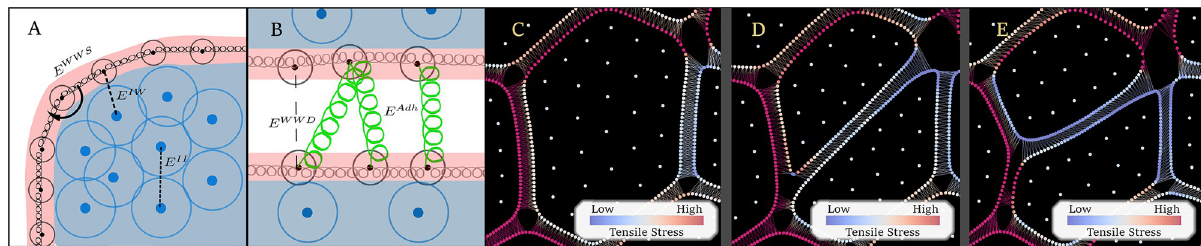
Fig 10. Two-dimensional multi-scale model of SAM growth and maintenance. Simulated cells are represented by two collections of nodes: cell wall nodes (solid black dots in the red region in A and B) and internal nodes (solid dark blue dots in the blue region in A and B). (A) Adjacent wall nodes of the same cell are shown interacting via linear and rotational springs given by E WW that represent mechanical stiffness and extensibility of the primary cell wall. Pairs of internal nodes and internal and cell wall nodes of the same cell are shown interacting via Morse potential functions given by E II , E IW that represent cell turgor-pressure. (B) Wall nodes of neighboring cells may form adhesion partners and interact via a linear spring potential given by E Adh that represents the adhesive properties of the middle lamella. Wall nodes of adjacent cells enforce cell-cell volume exclusion via Morse potentials given by E WWD . The division process in the model is demonstrated in C-E, with the cell on display dividing in response to in-plane tensile stress. The heat map shown in C-E represents in-plane tensile stress tensile stress on each node where warmer colors represent nodes under higher tensile stress, and cooler colors represent nodes under lower tensile stress. (C) A simulated cell nearing mitotic phase. (D) A pair of simulated cells shortly after division. Cytoplasm nodes are redistributed within the daughter cells and adhesion partners of each wall node are updated. (E) The same cells as in D after an elastic relaxation phase occurs.